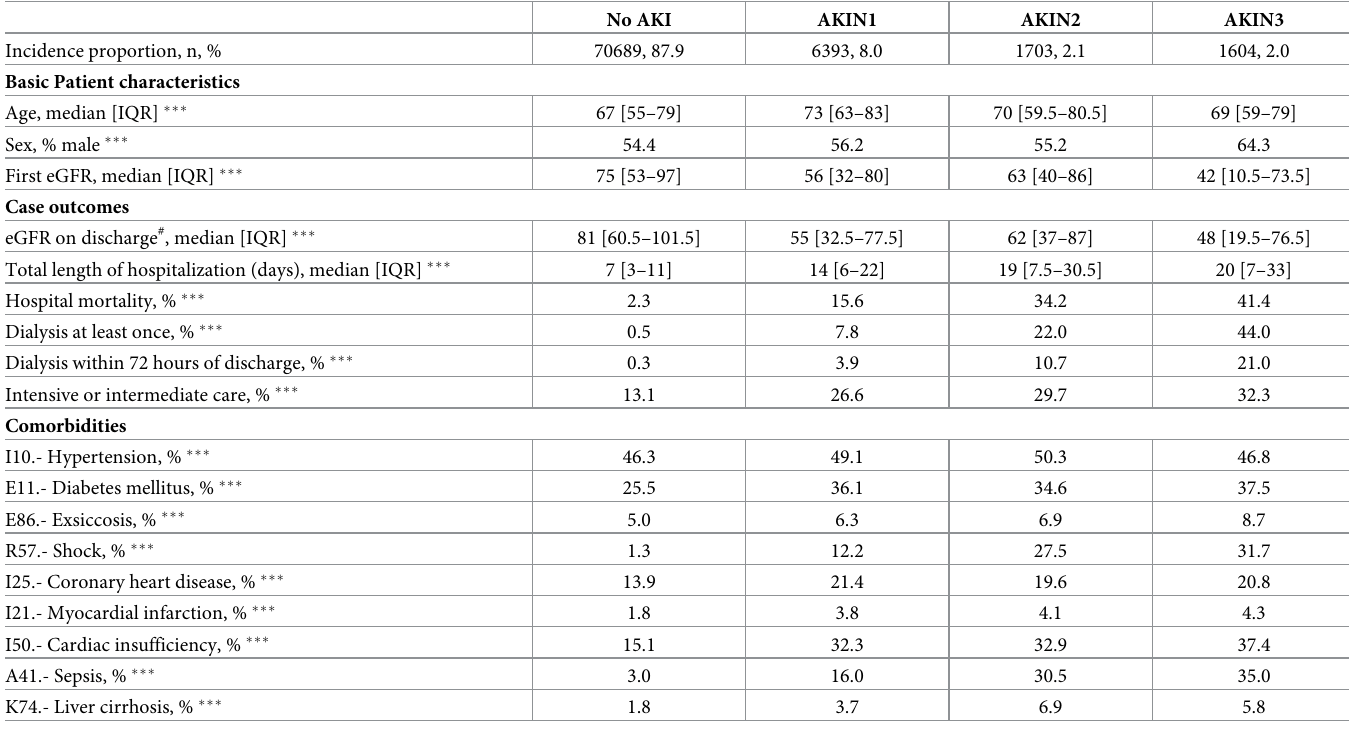
Table 3. Patient characteristics and comparison of the incidence, case outcomes and comorbidities among the AKI stages. No AKI AKIN1 AKIN2 AKIN3 Incidence proportion, n, % 70689, 87.9 6393, 8.0 1703, 2.1 1604,